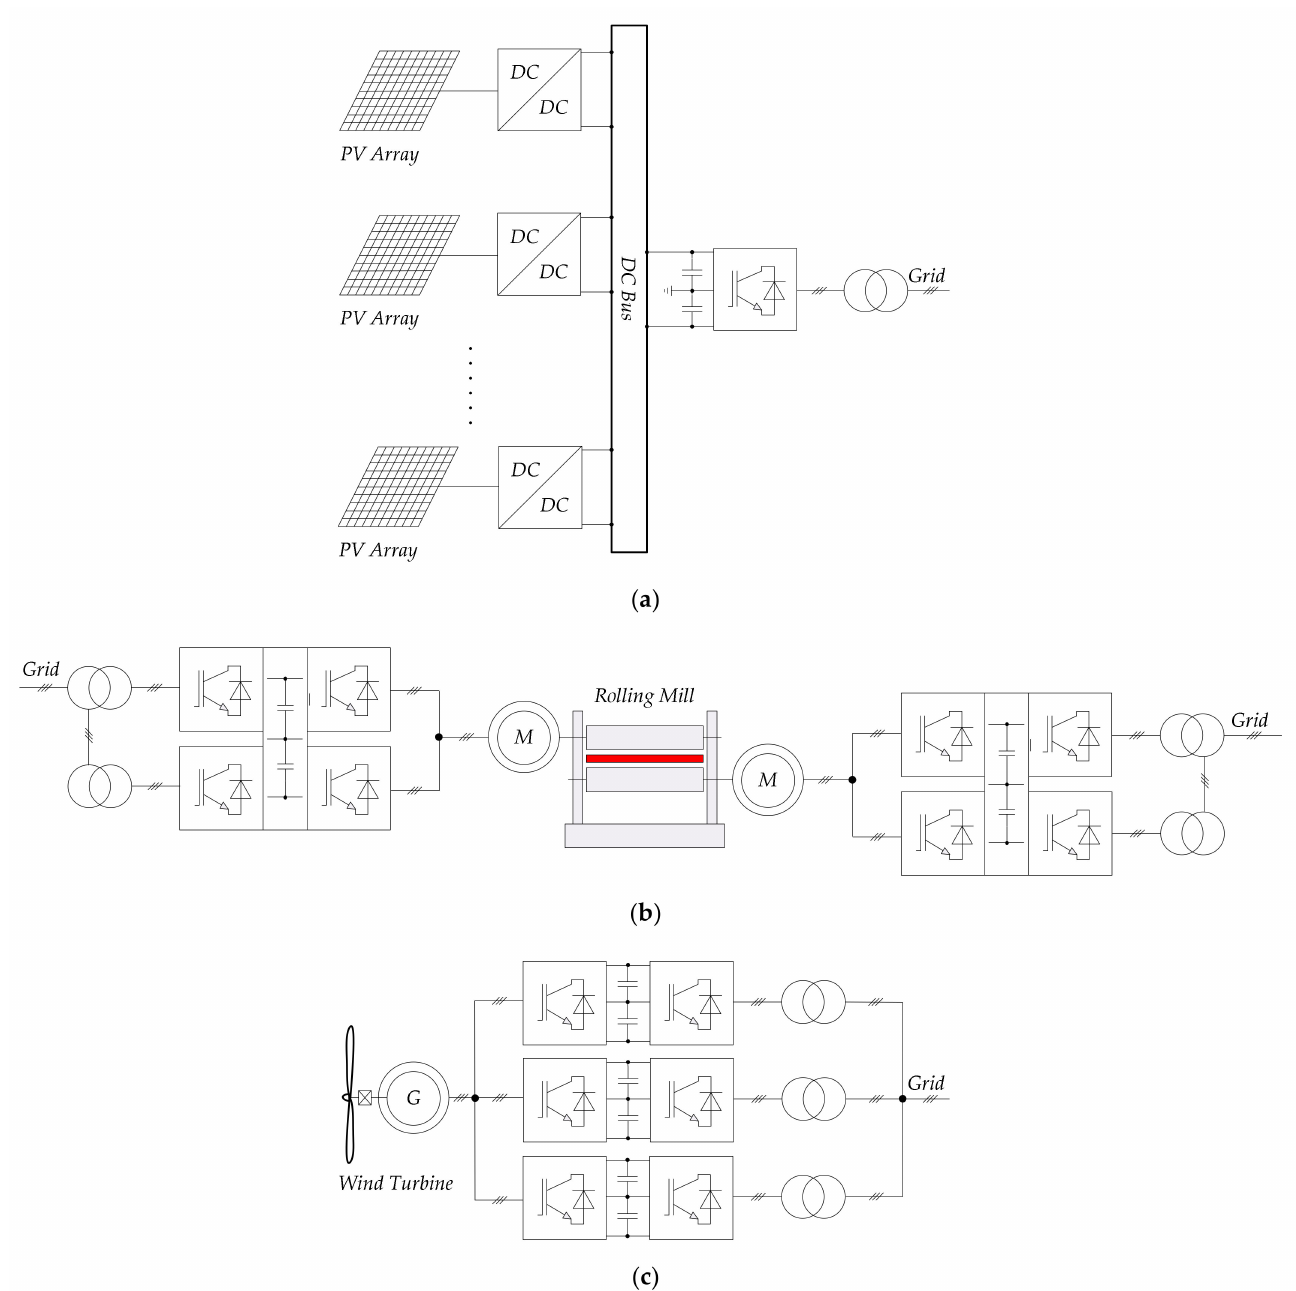
Figure 1. Several specific industry applications of high-power AFE converters: ( a ) Photovoltaic appli- cation with six-pulse connection scheme; ( b ) Rolling mill application with twelve-pulse connection scheme; and ( c ) Wind power application with eighteen-pulse connection